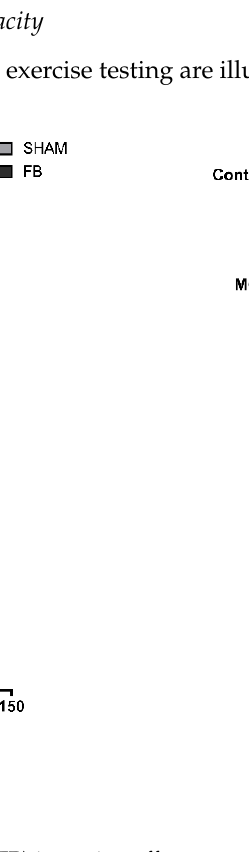
Figure 2. Xanthohumol-fortified beer (FB) ingestion effect on animal VO2max ( a ) time to exhaustion ( b ) and maximum speed that the animals reached on the test ( c ). Data are mean ± SEM of 6 animals per group. * p < 0.05 vs. respective control group, † p < 0.05 vs. MCT + SHAM. MCT: